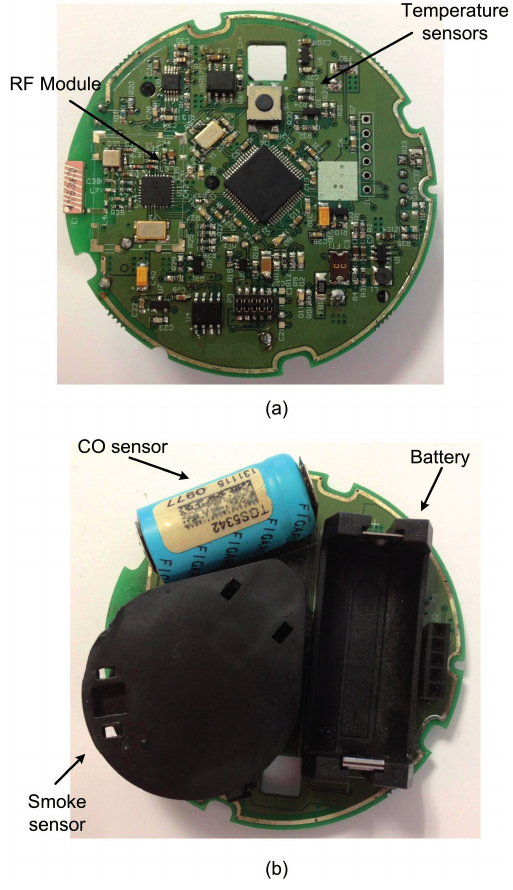
Figure 5. Main board of the fire sensing device. ( a ) Top; ( b ) Bottom.